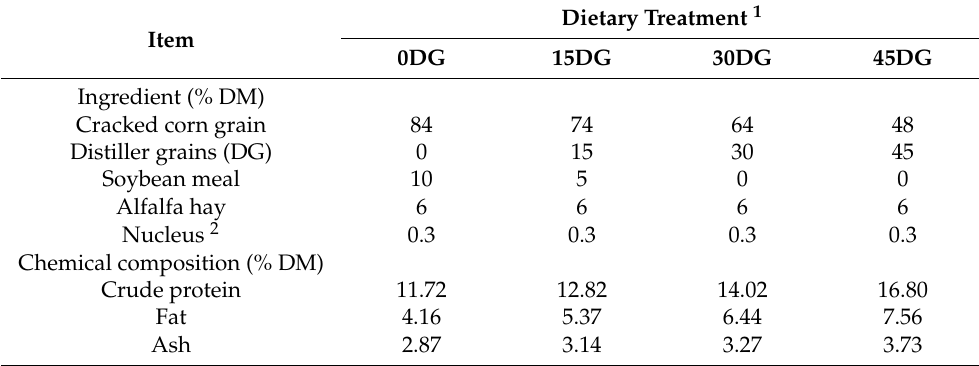
Dietary Treatment